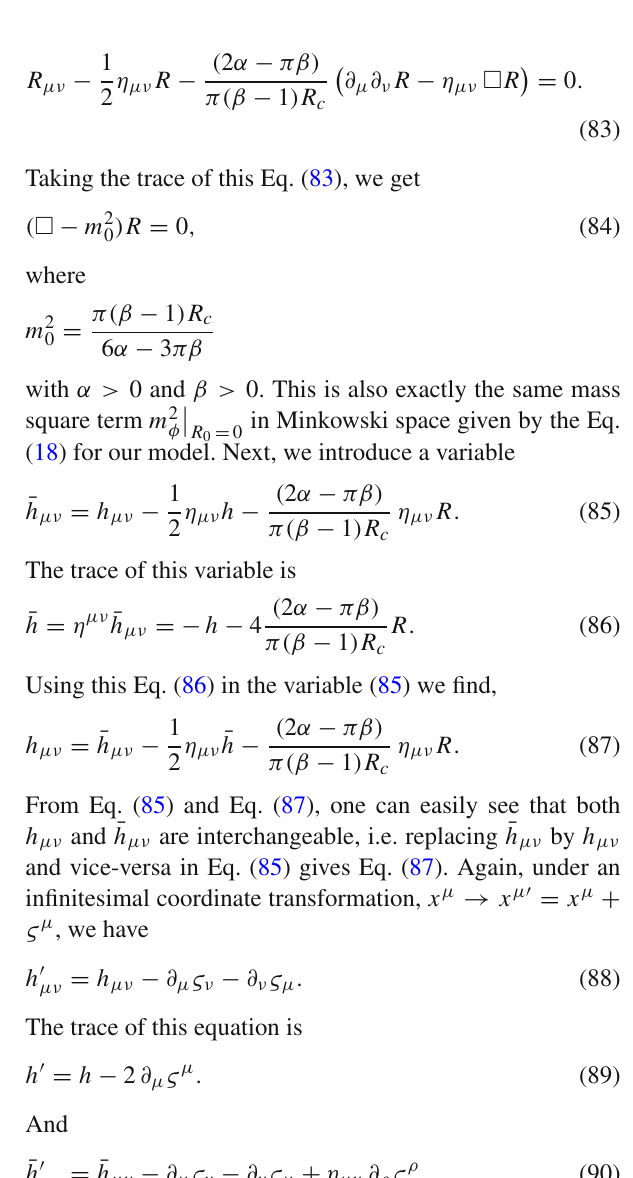
Fig. 15 Plot on left shows the variation of λ g with respect to R 0 , plot in middle shows the variation of f (cid:2) ( R ) − 1 with respect to R 0 and plot on right shows variation of m g with respect to f (cid:2) ( R ) − 1 for (i) = 30 × 10 − 50 m − 2 ; (ii) α = 0 . 045 ,β = α = 0 . 150 ,β = 0 . 500 , R c